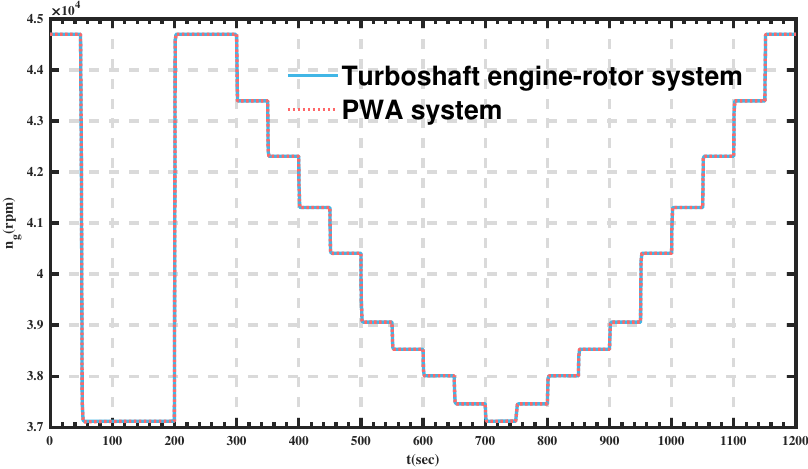
Figure 8. Speed response curves of power turbine.